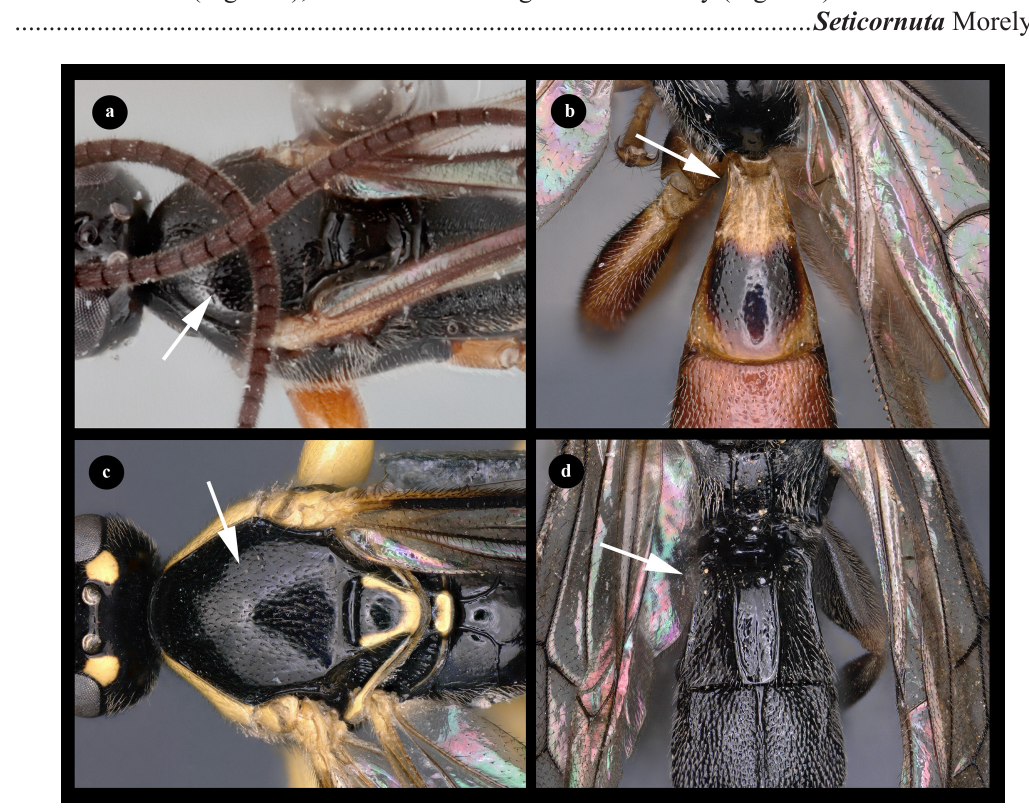
Fig. 10. a . Sciron fundator Fitton, 1984, mesosoma, dorsal view. b . Colpotrochia sp., metasomal tergite 1, dorsal view. c . Exochus sp., mesosoma, dorsal view. d . Trieces orientalis Ranjith & Priyadarsanan, 2022, metasomal tergite 1, dorsal view. Arrow in Fig. 10a points to the presence of notauli on mesoscutum (compared to the absence of notauli on mesoscutum in Fig. 10c). Arrow in Fig. 10b points to metasoma petiolate anteriorly (compared to broad metasoma anteriorly in Fig.